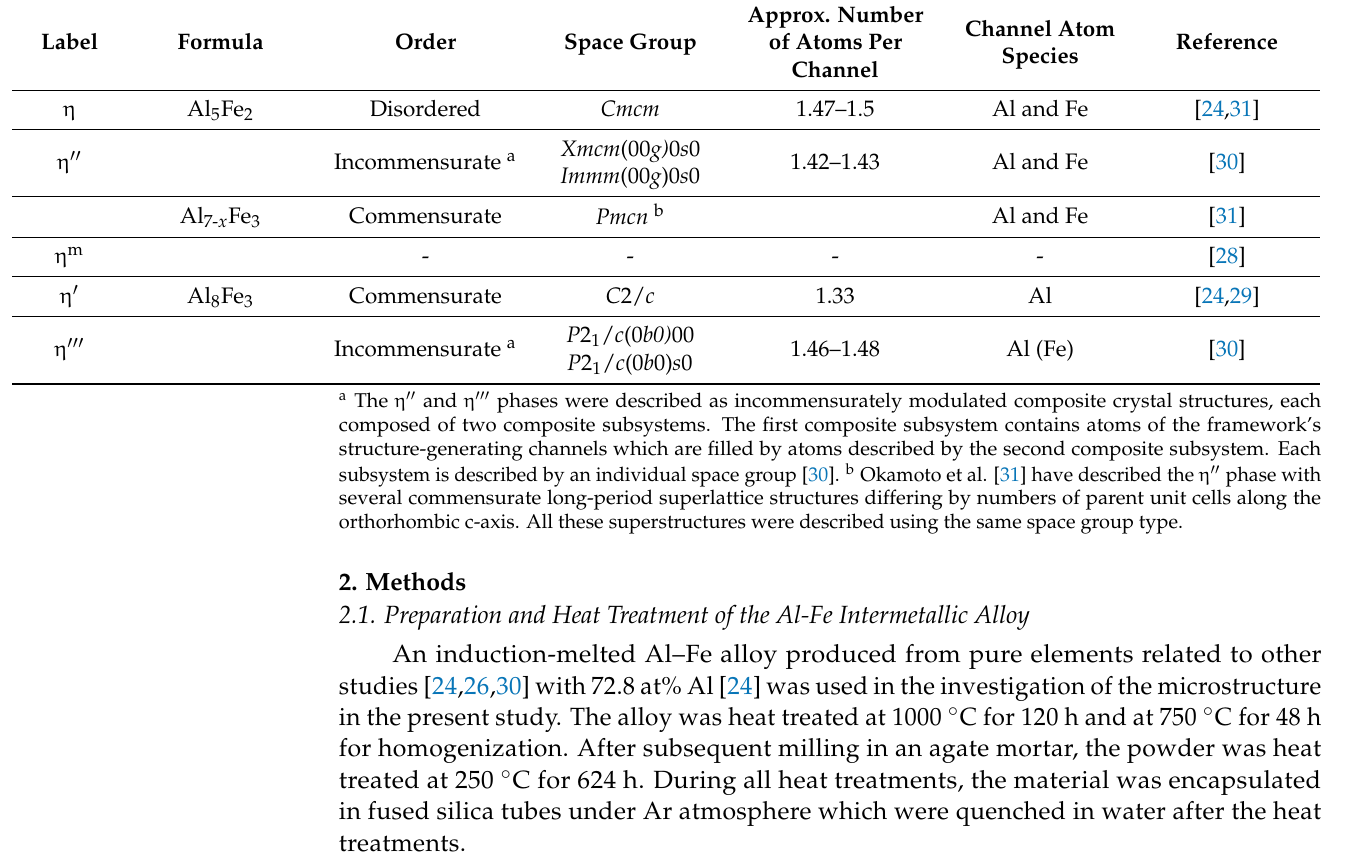
Table 2. In the case of the η (cid:48) phase, an η -like subcell (primed lattice basis vectors in Figure 1c,d) of the superstructure is used. In contrast to that of the η (cid:48)(cid:48)(cid:48) phase, however, this cell shows a visible monoclinic distortion, i.e., the β angle deviates from 90 ◦ by approx. 0.5 ◦